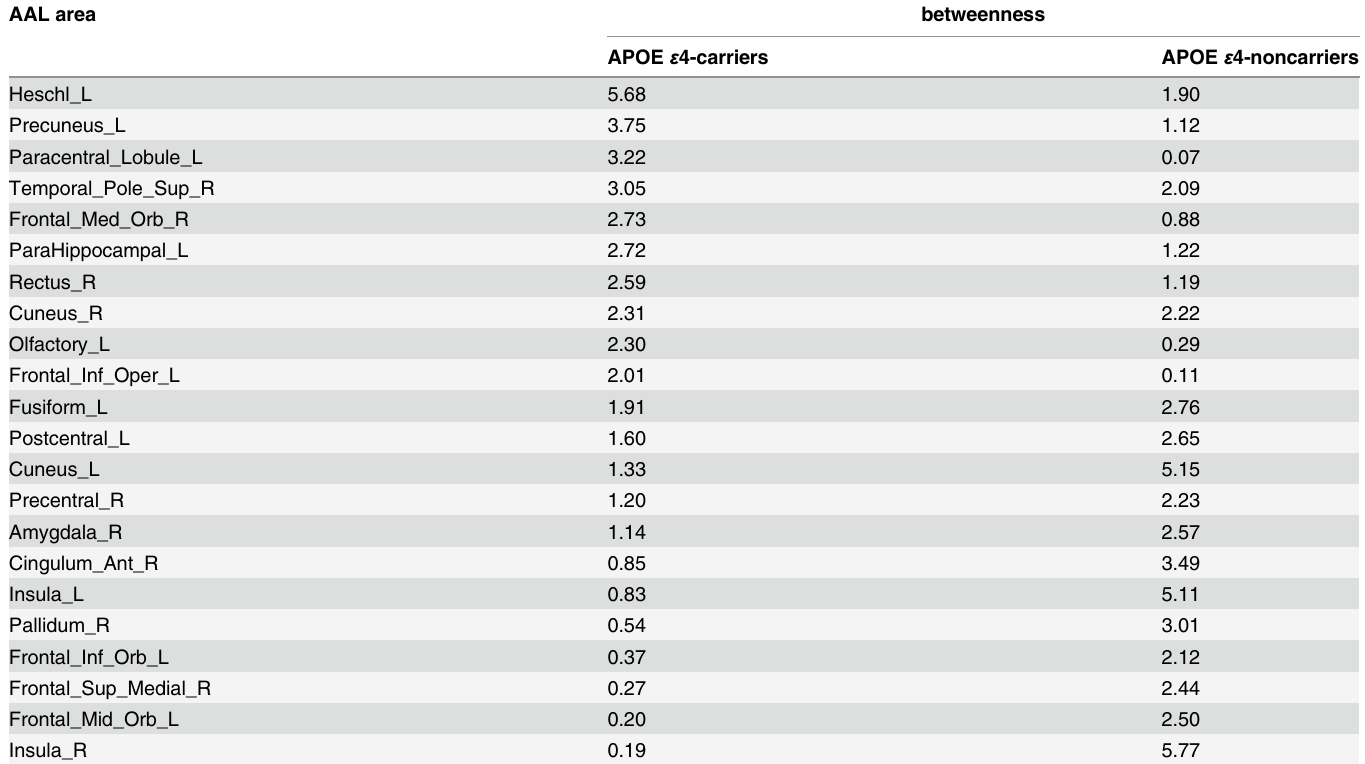
Table 1. Hub regions in metabolic networks of the APOE ε 4 carriers and the APOE ε 4 noncarriers listing by the descending order of the APOE ε 4 carriers ’ normalized betweenness. AAL